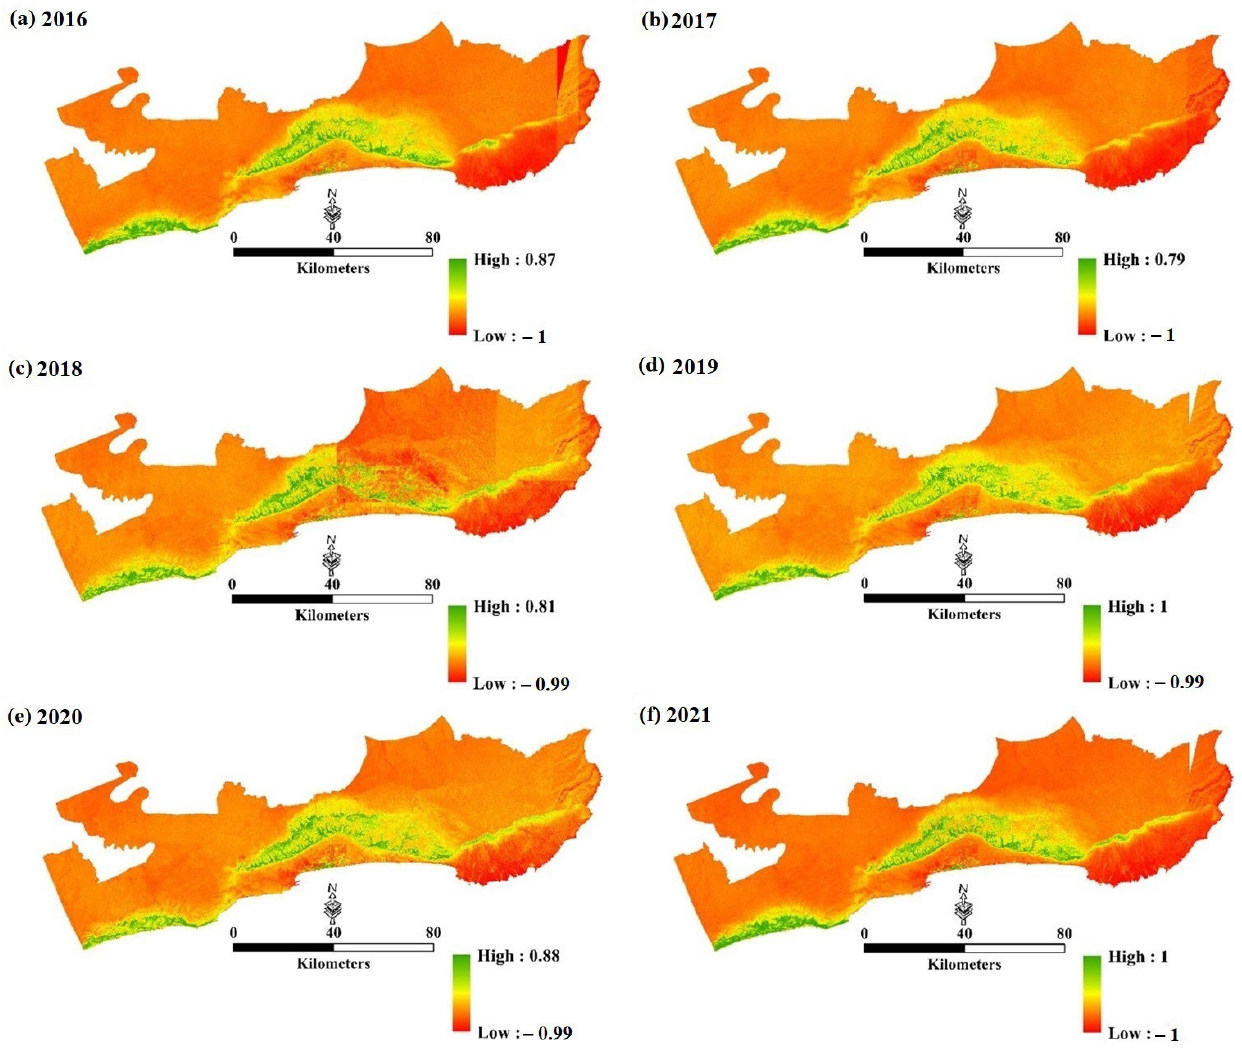
Figure 5. Displays how NDVI values varied over time and space across the study area during the period from 2016 to 2021 ( a – f ).